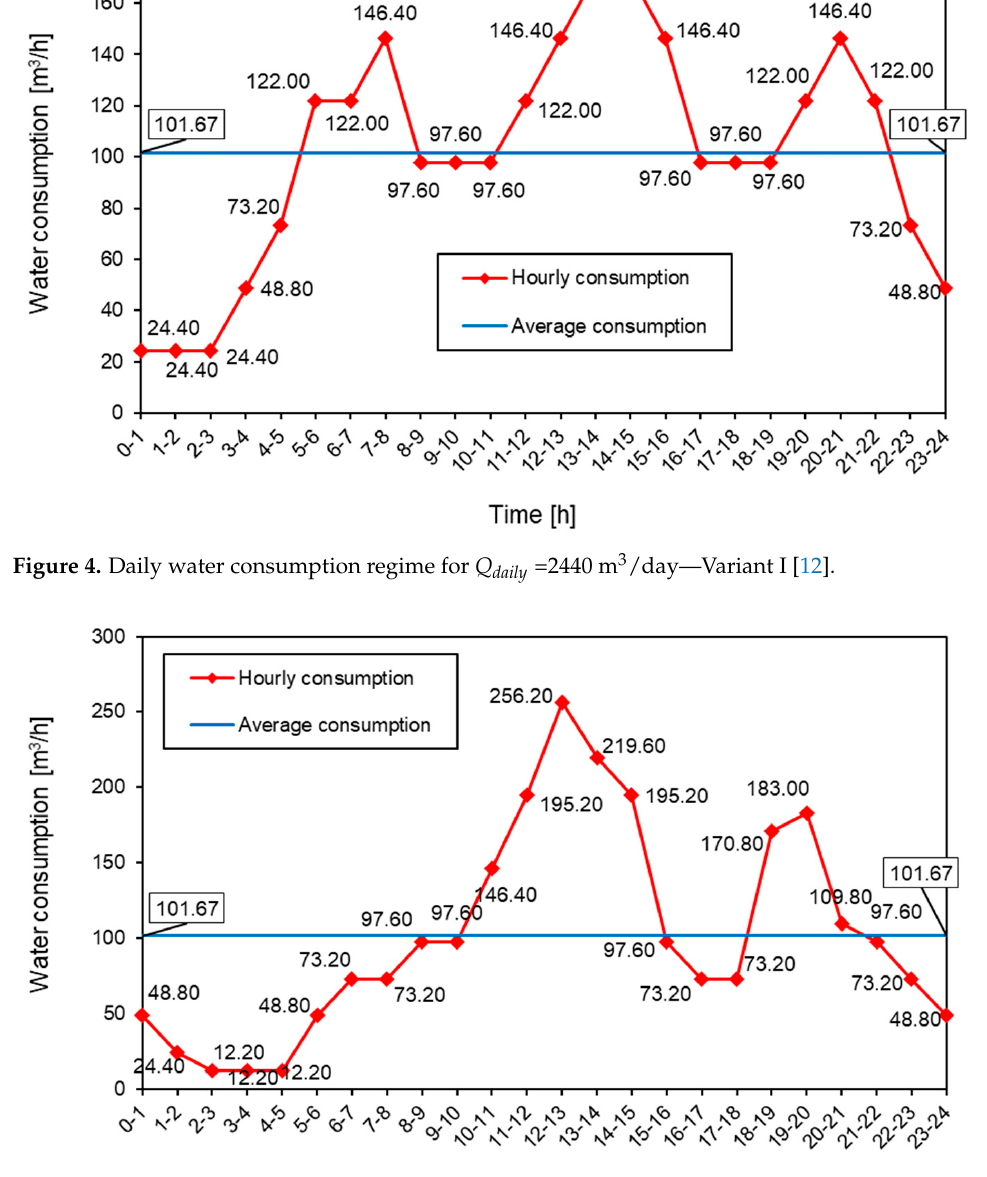
Figure 5. Daily water consumption regime for 𝑄 𝑑𝑎𝑖𝑙𝑦 = 2440 m 3 /day—Variant II [12].